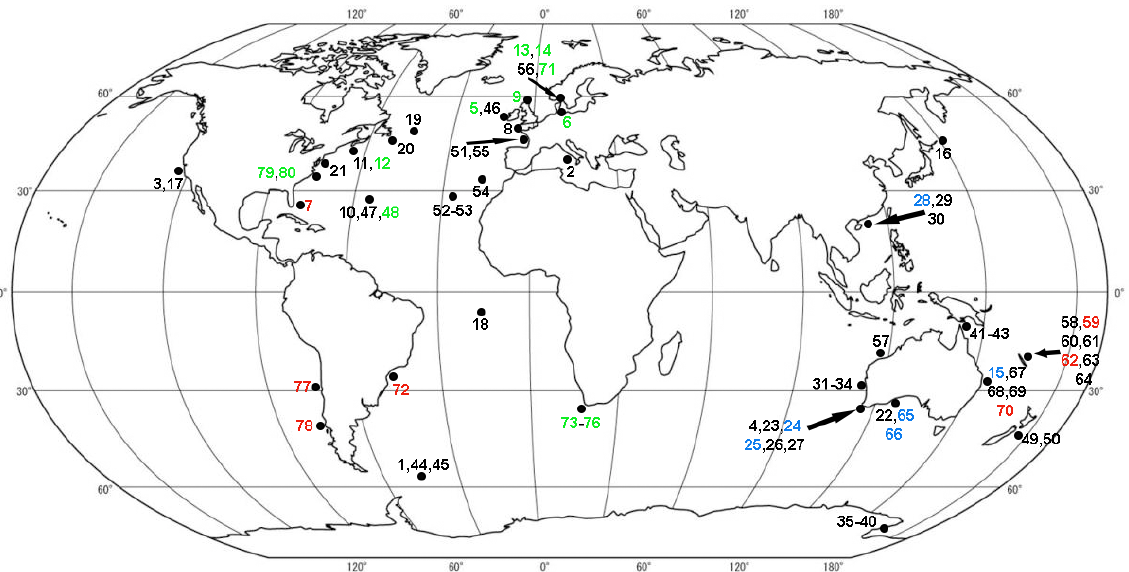
Fig. 2. World map showing the description localities, and the three evolutionary lineages (color-marked) of Grania spp. genetically analyzed by Prantoni et al. (2016: clades A, B and C). Green numbers = Atlantic species (clade A); red numbers = South Pacific and Atlantic species (clade B); blue numbers = Australian and Asian species (clade C); black numbers = species presently without molecular data, i.e., not yet allocated to any particular